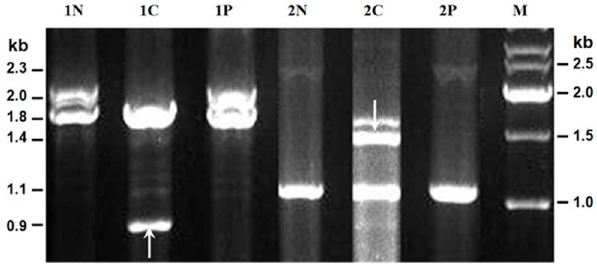
Figure 3. Instability of MUC5AC-u repetitive region in normal, para-carcinoma, and cancer tissues from patients with gastric cancers. Genomic DNA was analyzed from cancer, para-carcinoma and surrounding normal tissues of patients. The sizes of MUC5AC-u repetitive region were analyzed by PCR. N indicated gastric normal tissues, C indicated cancer tissues, P indicated para-carcinoma tissues, and M indicated the size marker. Rearrangements in cancer tissues are indicated by arrows. Heterozygotes have an additional hetero-duplex band (lane of 2C). doi:10.1371/journal.pone.0098327.g003 PLOS ONE |